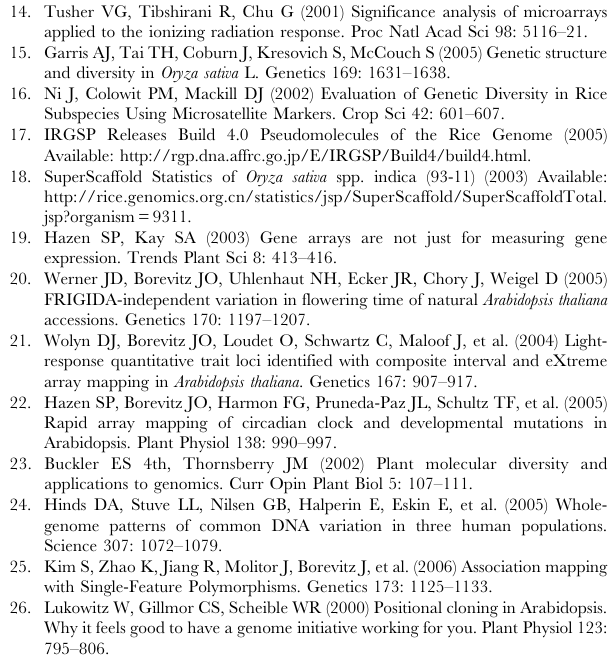
Table S3 In-silico predicted SFPs and their